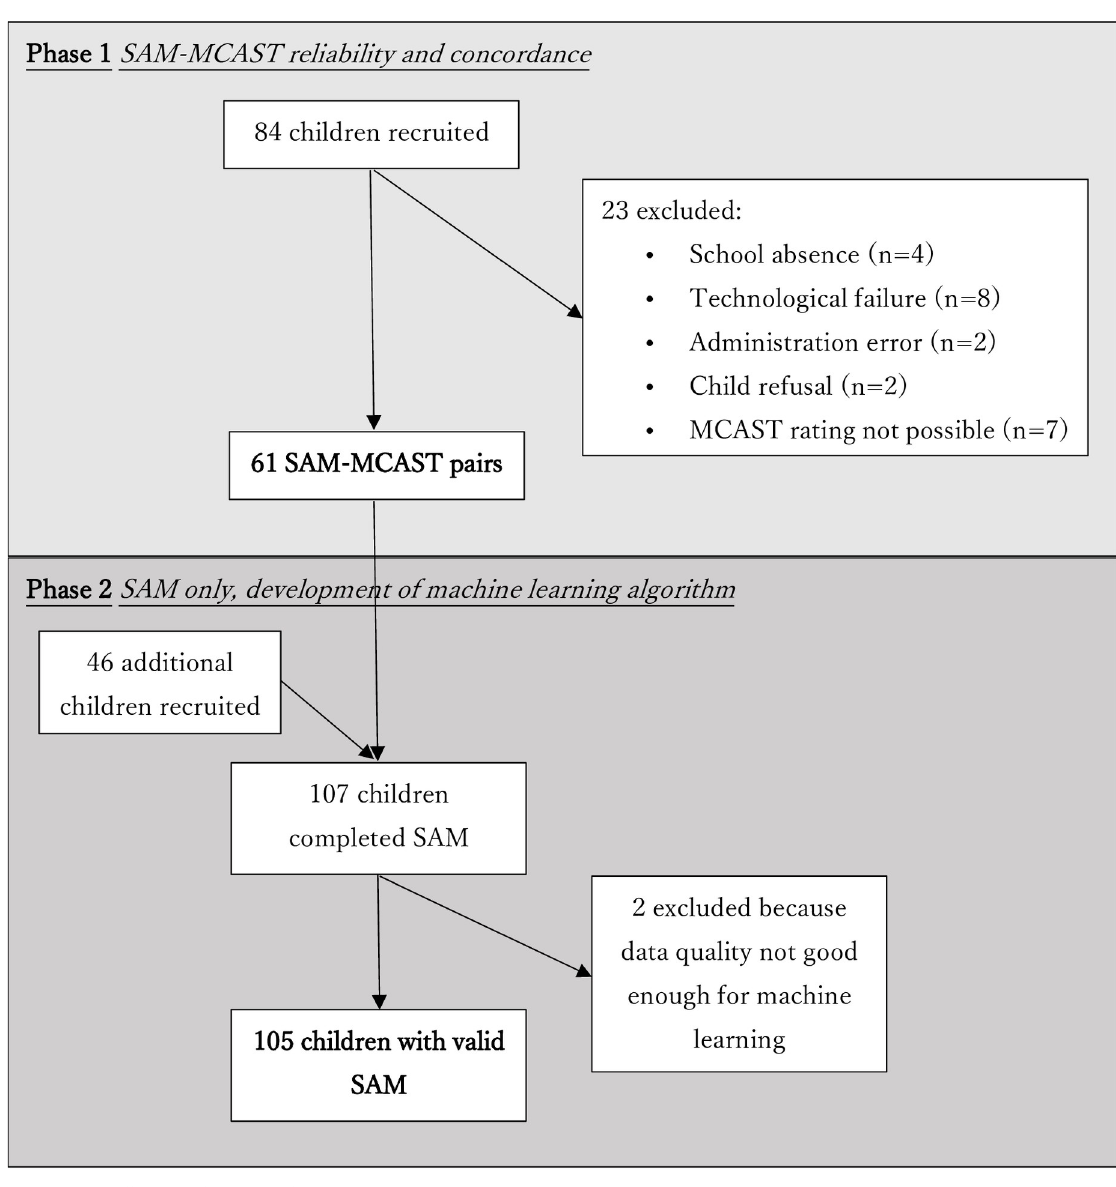
Fig 2. Data collection Phases 1 and